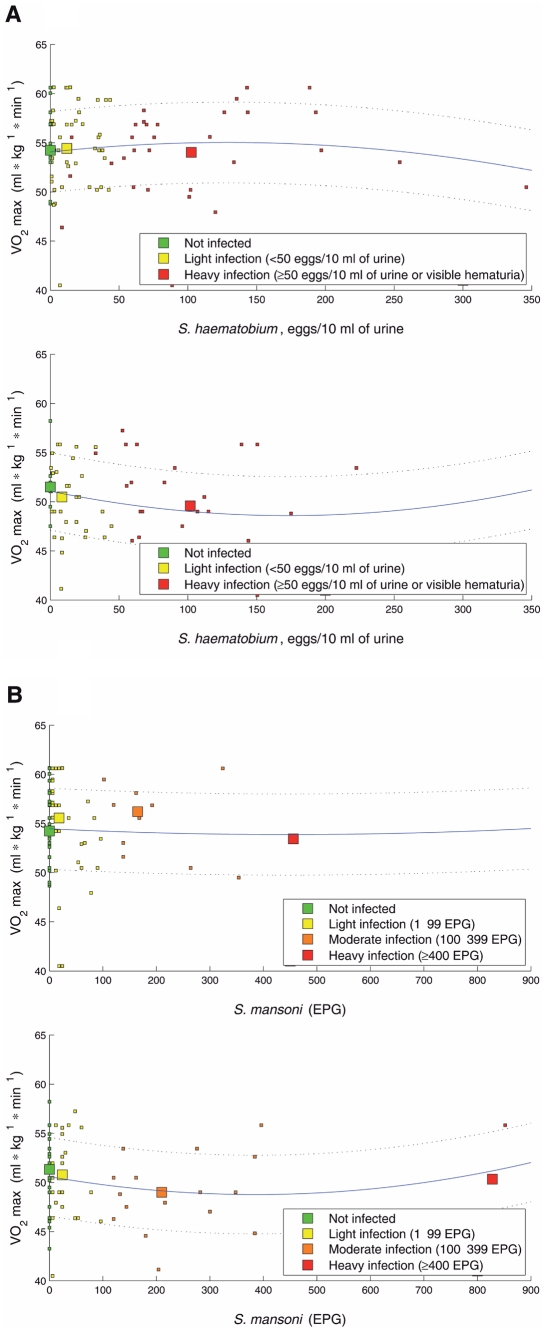
Sex-specific scatter plots of VO2 max values among Ivoirian school children.VO2 max values were obtained from 156 children attending grades 4-6 in the primary school of Grand Moutcho II and III near Agboville, south Côte d'Ivoire in early 2010 after performing a 20 m shuttle run test. Data are shown in accordance with children's infection status of S. haematobium, measured in number of eggs per 10 ml of urine (A), and S. mansoni, measured in number of eggs per gram of stool (EPG) (B). Scatter plots on the top represent males and scatter plots on the bottom females. Second order polynomial regression lines (solid lines) and their 95% confidence intervals (dotted lines) are presented.